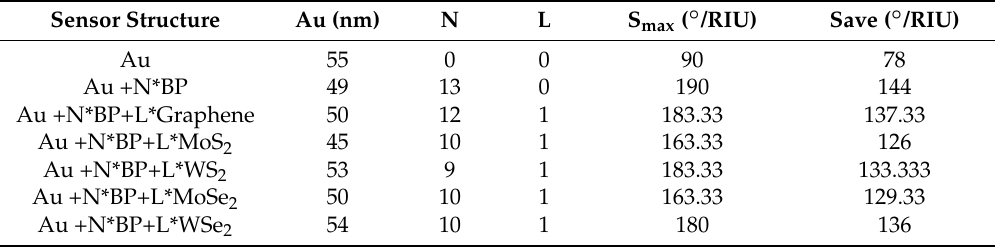
Table 4. Genetic